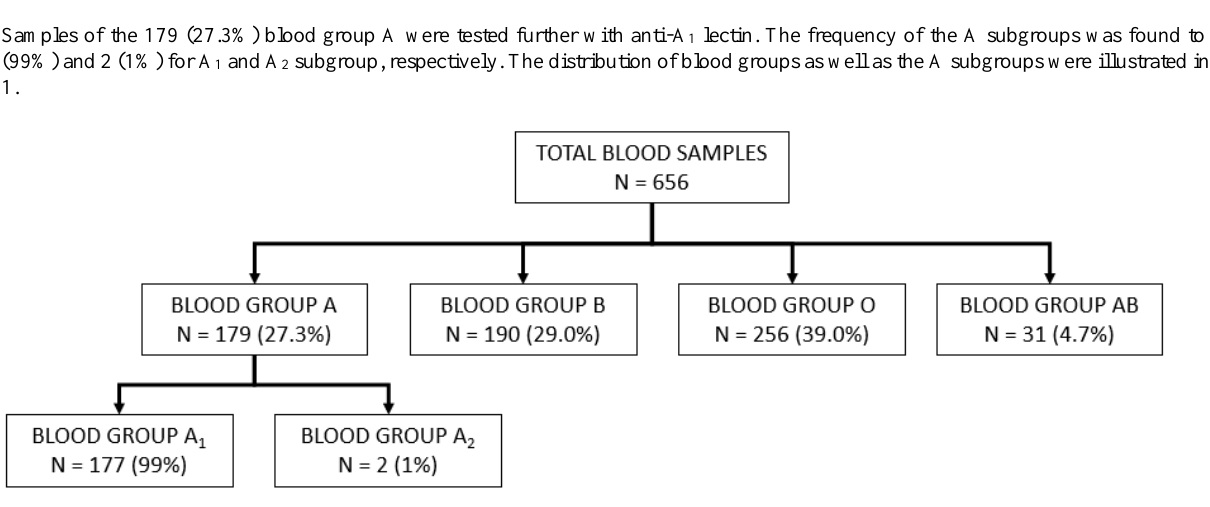
Figure 1: Blood group A subgroup distribution. Blood group A 2 was determined using anti-A 1 lectin. The two samples of blood group A that were negative with anti-A 1 lectin were selected for further test and the sample are labelled as sample 1 and sample 2. The result of forward and reverse blood grouping, anti-A1 lectin, and anti-H antigen detection for sample 1 and 2 are presented in Table 2. Table 2: Agglutinated grades were gradually increased from (+) to (4+). Serologic reaction between sample 1 and